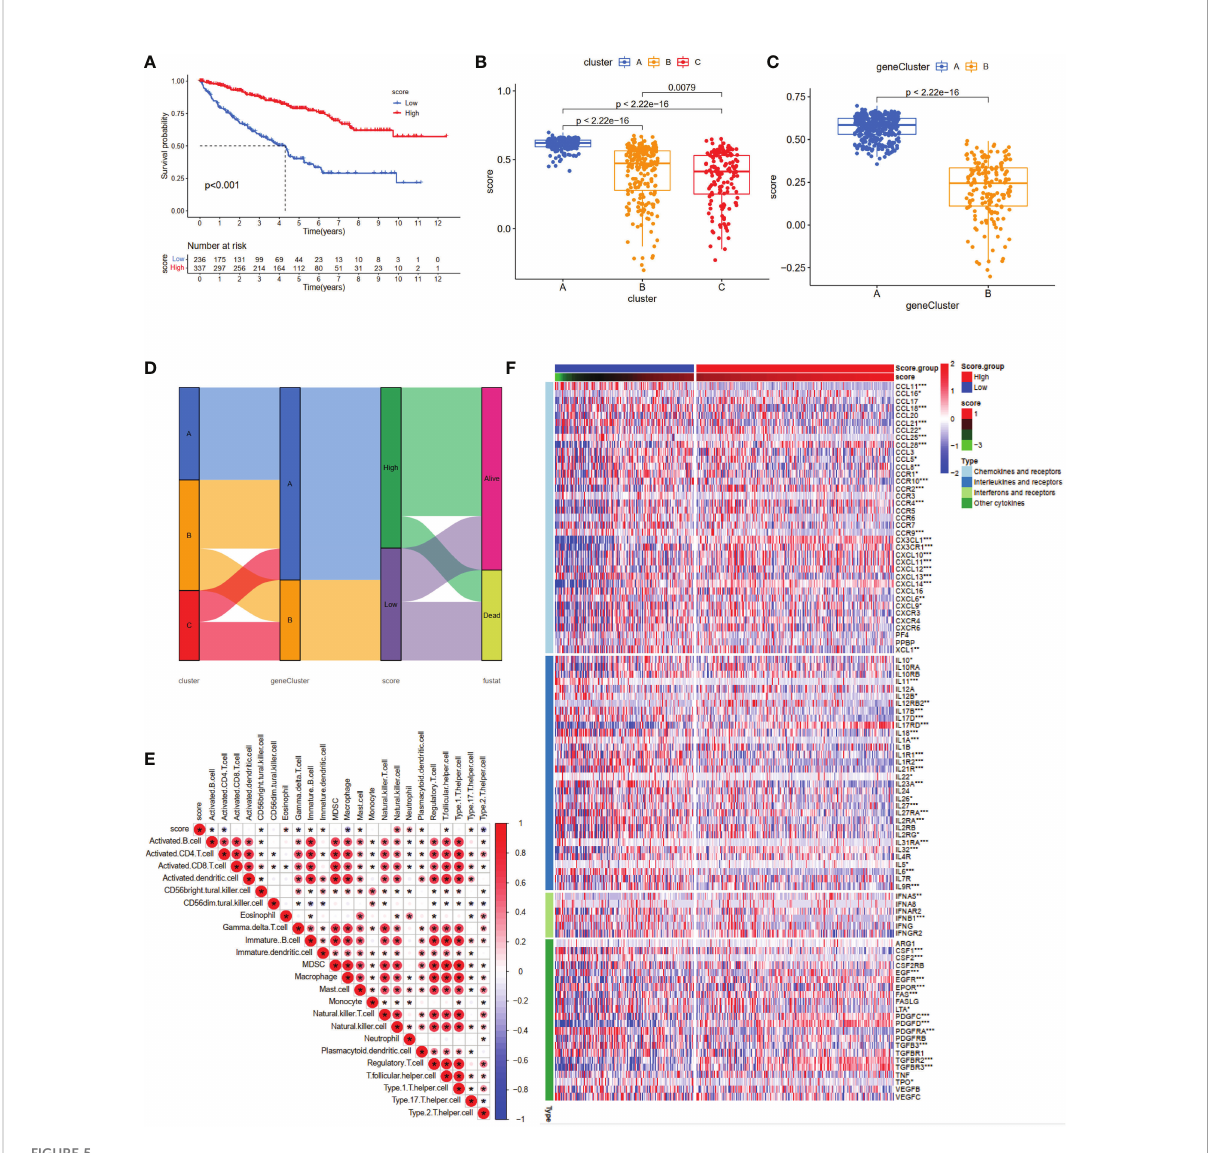
FIGURE 5 Construction of the NET-score system and clinical prognosis analysis in ccRCC patients. (A) Kaplan – Meier curves for high and low NET-score ccRCC patient groups (log-rank test, P < 0.001). Differences in NET scores among the three clusters (B) (P <0.001) and two gene clusters (C) (P <0.001). (D) Alluvial diagram of NET-associated gene clusters in groups with different gene clusters, NET-score groups, and survival outcomes. (E) The correlation matrix of all in fi ltrating immune cells. Some fractions of immune cells were positively related and are represented in red, whereas others were negatively related and are represented in blue. p <0.05 was the cut-off. (F) Heatmap showing the relationship between scoring groups and chemokines, interferons, and cytokines. *p < 0.05, **p < 0.01, ***p <